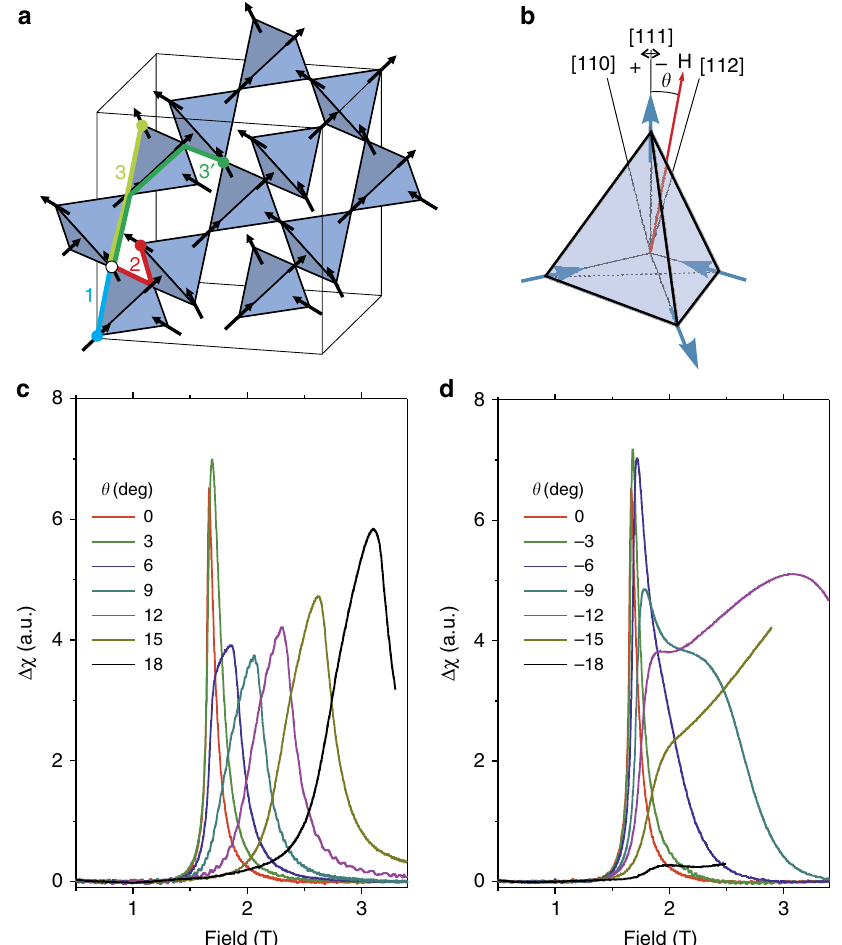
Figure 1 | Magnetic susceptibility at the polarization transition. The data shown are from HTO, but are representative of both materials. ( a ) A schematic view of the pyrochlore lattice: spins are represented as black arrows, and tetrahedra are coloured light blue. The coloured lines show, starting from the white circle, a first (light blue), second (red) and two types of third (green and light green) nearest neighbour. ( b ) Sign convention for the angle shown in a single tetrahedron: rotations towards [112] are negative while those towards [110] are positive. ( c ) Magnetic susceptibility: when the field is rotated towards [110] the peak remains unique. ( d ) As the field is rotated towards [112], the peak splits into two, the upper one moves faster with field as the angle is increased. The temperature for all curves is fixed at 0.18K and in all cases a smoothly varying background has been subtracted for